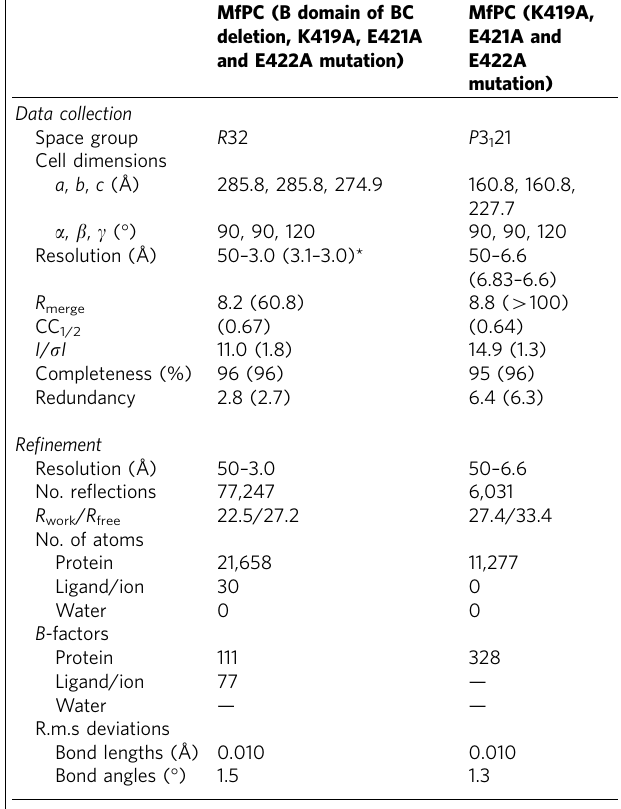
Three crystals were used for data collection for mutant MfPC, and one crystal for wild-type MfPC. *Highest-resolution shell is shown in parenthesis.